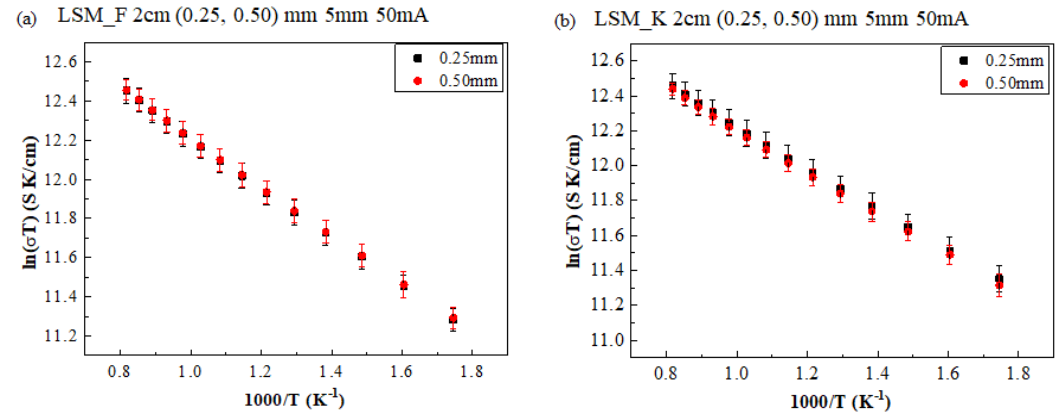
Figure 6. Arrhenius plot of measured electrical conductivity according to lead wire diameter: ( a ) LSM-F and ( b ) LSM-K.